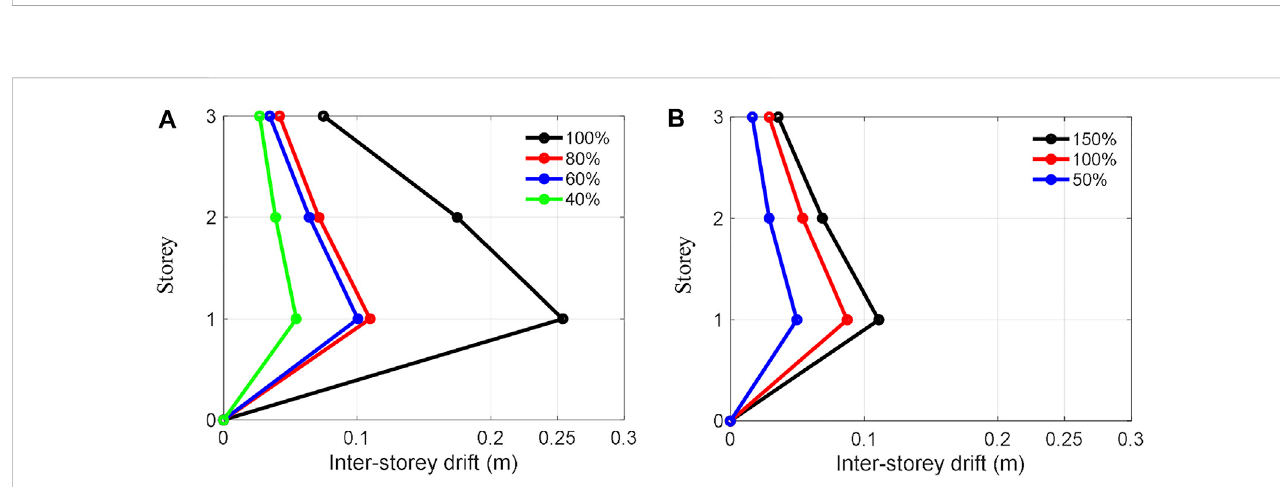
FIGURE 7 Maximum inter-storey drift of the structure excited by (A) Takatori motion and (B) Nankai motion.